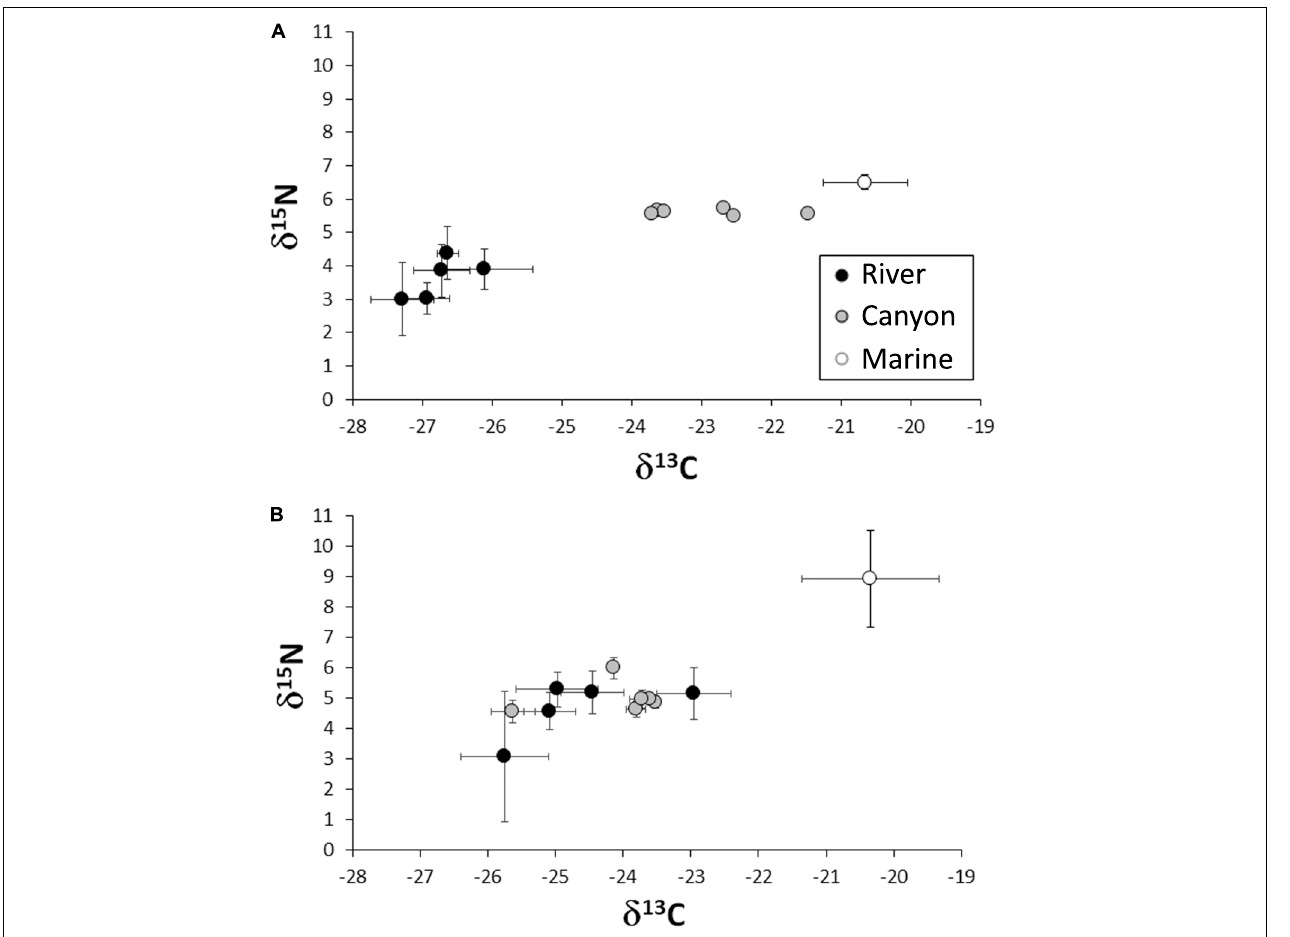
FIGURE 4 | Bulk δ 13 C and δ 15 N values of river, canyon and marine sediment from: (A) Kaik¯oura Canyon (single samples have no error bars) and (B) Hokitika Canyon. Error bars ( ± 1 standard deviation) are